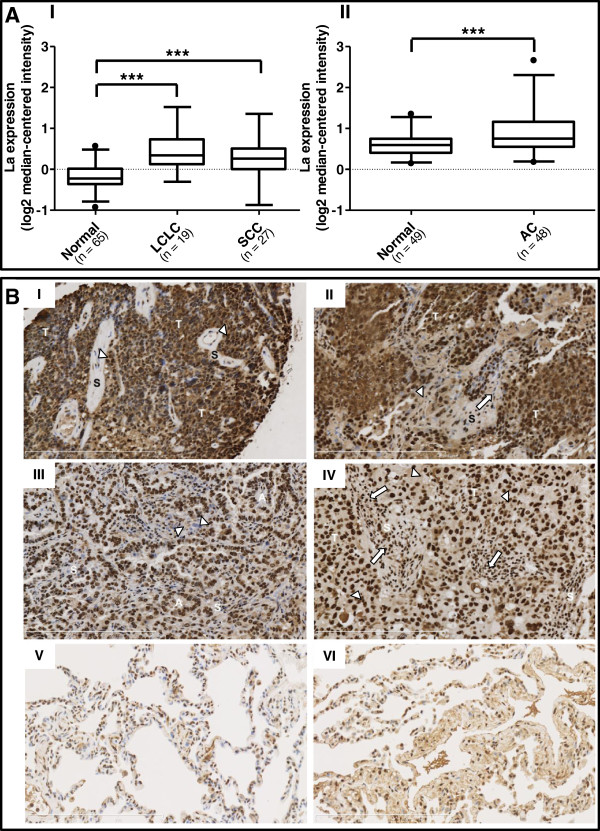
Expression of La mRNA and protein in lung cancer. (A) The expression of La mRNA in normal compared to lung cancer samples was examined using the online database Oncomine. Two studies showed increased La mRNA expression in lung cancer samples compared to normal lung tissue. Data was taken from (I) Hou et al.’s study
[30] and (II) Landi et al.’s study
[29]. Data are shown with 95% confidence intervals and circles representing outliers. LCLC, large cell lung cancer; SCC, squamous cell lung cancer; AC, adenocarcinoma. *** p < 0.001. (B) Photomicrographs of DAB4 staining pattern in sections of resected human lung tumours. TissueFocus Cancer Survery Tissue Microarray (Origene) was examined via immunohistochemistry for DAB4 expression. (I) Poorly differentiated squamous cell carcinoma of bronchus (case No. 0000019032): tumour cells (T); hypocellular stroma (S) with variable DAB4 expression (evident as brown staining) of normal cells including endothelial cells and other stromal cells (arrowheads). (II) Adenosquamous carcinoma (case No. 0000016518): predominantly basaloid squamous cell carcinoma (T) with prominent DAB4-stained nucleoli (arrowheads); desmoplastic stromal reaction (S) with both DAB4-stained and unstained nuclei of stromal cells (arrow). (III) Poorly differentiated adenocarcinoma (case No. 0000008378): acinar structures (A) are evidently interweaved with a hypercellular stroma (S). Some malignant cells were not stained with DAB4 (arrowheads). (IV) Poorly differentiated lung adenocarcinoma (case No. 0000016267): the high-grade malignant cells (T) are vacuolated and have weak non-specific cytoplasmic staining with DAB4 (arrowheads); a desmoplastic stromal reaction (S) with DAB4-stained lymphoplasmacytic infiltrates (arrows). (V and VI) Normal lung tissue (case No. 0000000144 and 0000006853) showed reduced, predominantly nuclear DAB4 staining. All sections are shown at × 20 magnification, and scale bars are indicated.